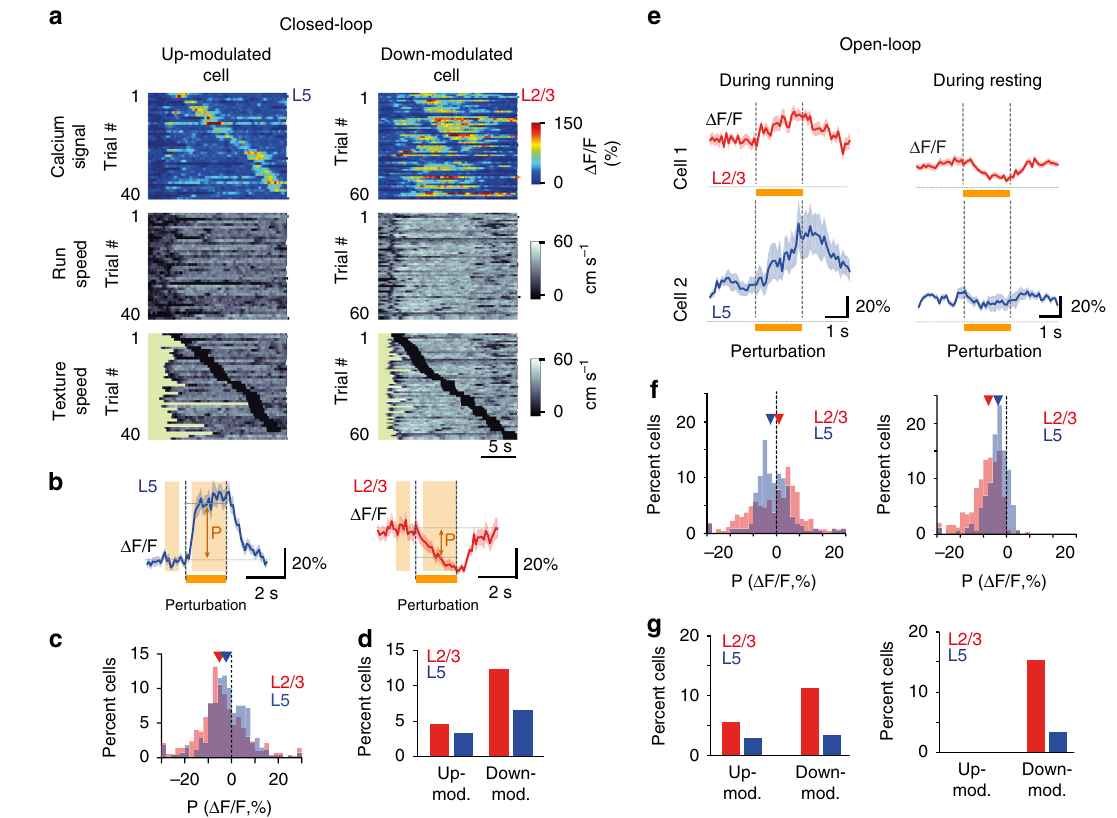
Fig. 5 A subset of neurons responds to perturbations of tactile fl ow. a Calcium signals for two example neurons across multiple Closed-loop trials. Trials are sorted according to when the perturbation (2-s texture halt) occurred. Running speed and texture speed are plotted below with black periods marking stop of texture rotation. The left L5 neuron is an example of an up-modulated cell whereas the right L2/3 neuron exempli fi es down-modulation upon perturbation. b Mean Δ F / F traces (±s.e.m.) aligned to perturbation onset for the example neurons in ( a ). ‘ P ’ indicates the amplitude of perturbation- induced modulation de fi ned as the difference between mean Δ F / F values before ( − 1 to − 0.3 s window) and during perturbation ( + 0.3 to 2 s, orange shaded areas). c Distribution of perturbation-induced modulation for all L2/3 (red, n = 420) and L5 (blue, n = 275) neurons. Triangles mark medians of − 5.1% and − 2.3% for L2/3 and L5 neurons, respectively. d Percentage of signi fi cantly up-modulated ( P > 2 σ ) and down-modulated ( P < − 2 σ ) neurons in L2/3 and L5 populations, respectively, with σ denoting baseline noise (see Methods). e Perturbation responses of two example neurons in Open-loop condition, where sudden stalling of the texture rotation may occur during running (left panels) or resting (right panels). f Distribution of perturbation modulation ( P ) for neurons in L2/3 (red, n = 269) and L5 (blue, n = 234) neurons during running (left panel, mean P : − 0.7 ± 0.7% and − 1.7 ± 0.6% for L2/3 and L5; p < 0.05) and during resting (right panel, 253 L2/3 neurons, red, and 172 L5 neurons, blue; mean P : − 9.2 ± 0.5% and − 4.3 ± 0.4% for L2/3 and L5, respectively, p < 0.0001). Wilcoxon rank sum test was used for distribution comparisons. g Percentage of neurons that are signi fi cantly up- modulated ( P > 2 σ ) and down-modulated ( P < − 2 σ ) for L2/3 (red) and L5 (blue) populations during running (left) and during resting state